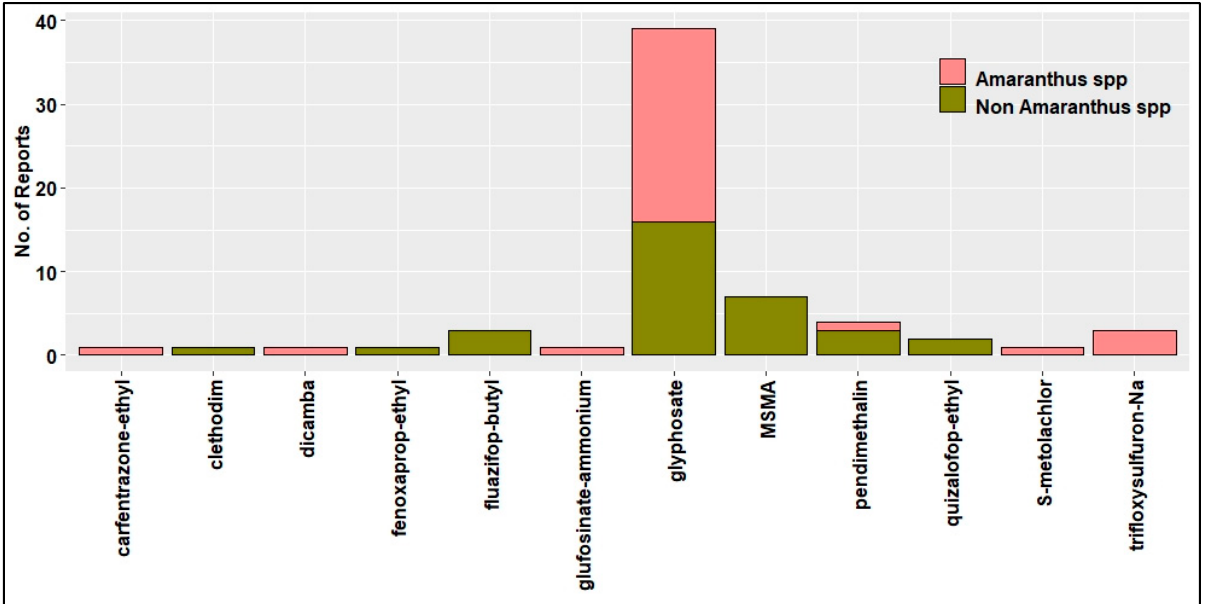
Figure 6. Reported cases of resistance to different herbicides in cotton production in the U.S [24]